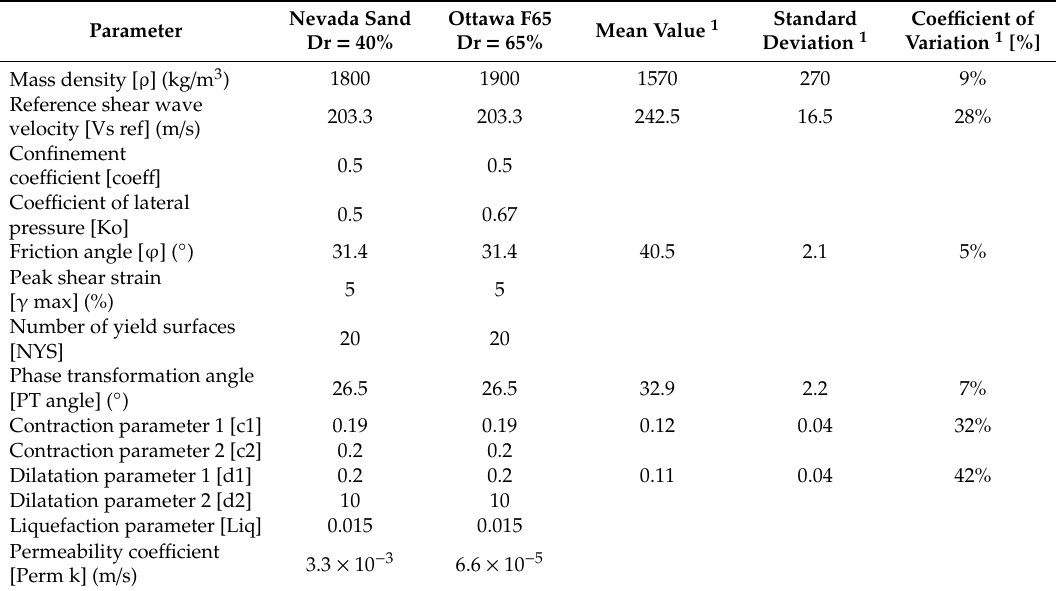
Table 3. Input variables for Cyclic1D’s numerical model.